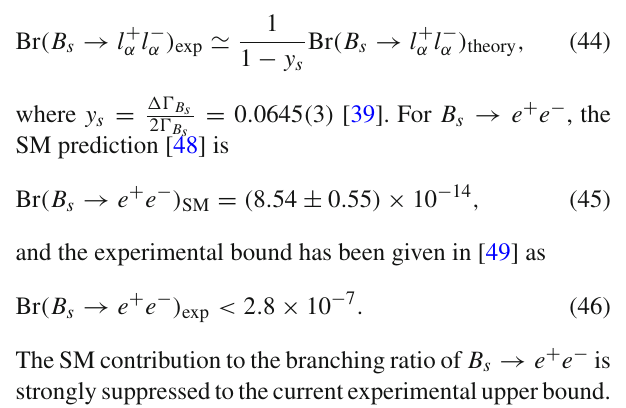
where τ B is the total lifetime of the B s meson. If s